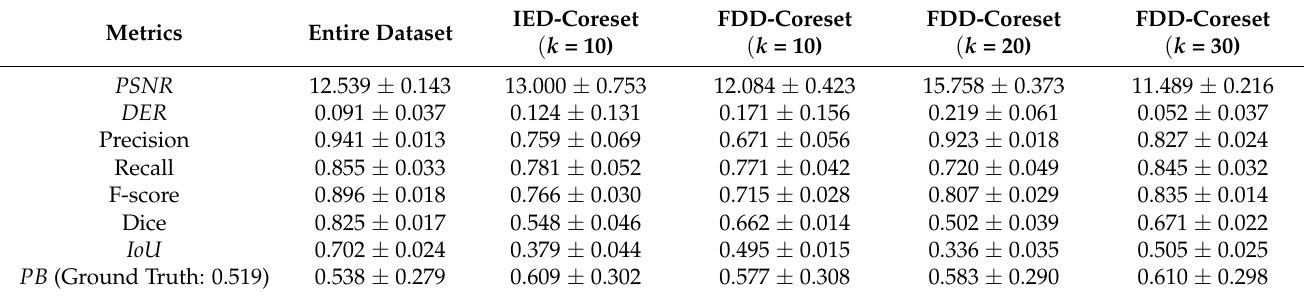
Table 3. Performance comparison (avg ± std) of BlobGAN trained on entire dataset (1000 Random Samples), IED-Coreset ( k = 10) and proposed FDD-Coreset ( k = 10, 20, 30) on 3D synthetic images.